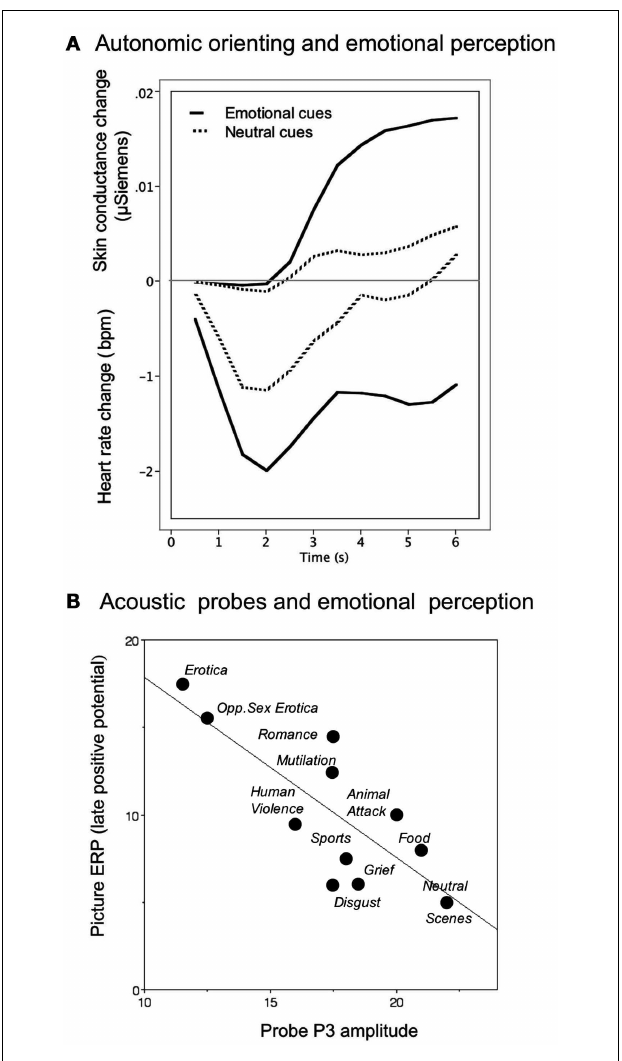
FIGURE 1 | (A) Temporal dynamics of orienting in heart rate and skin conductance during emotional perception, with heightened cardiac deceleration and electrodermal reactivity when viewing emotional, compared to neutral, pictures. (B) The amplitude of the P3 component elicited by the presentation of an irrelevant acoustic probe during picture perception is inversely related to the amplitude of the late positive potential elicited by the picture itself. Larger late positive potentials, indicative of greater resource allocation to emotionally arousing cues, is associated with less resource allocation to the probe, resulting in smaller probe